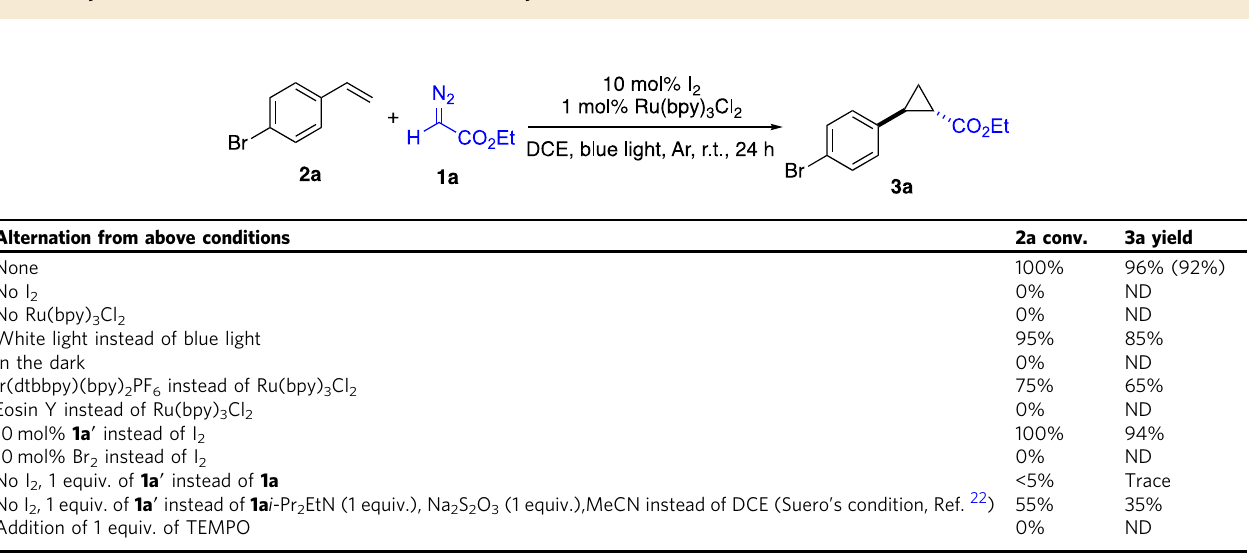
Table 1 Optimization of the reaction conditions under photo-initiated conditions